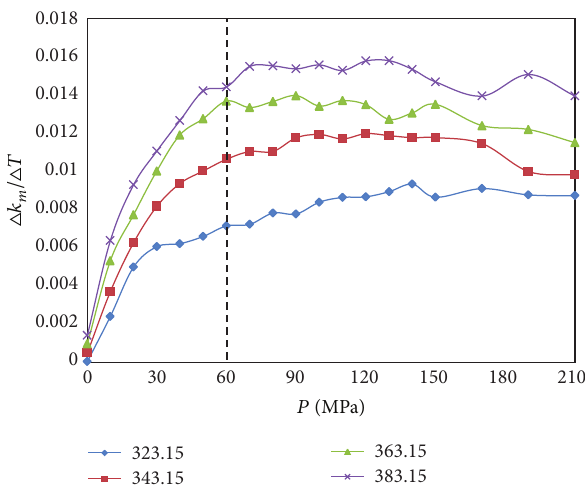
Figure 5: The trend of differential pressure of molecular compress- ibility temperature along various isothermal for ethyl caprate (only calculated values were revealed).